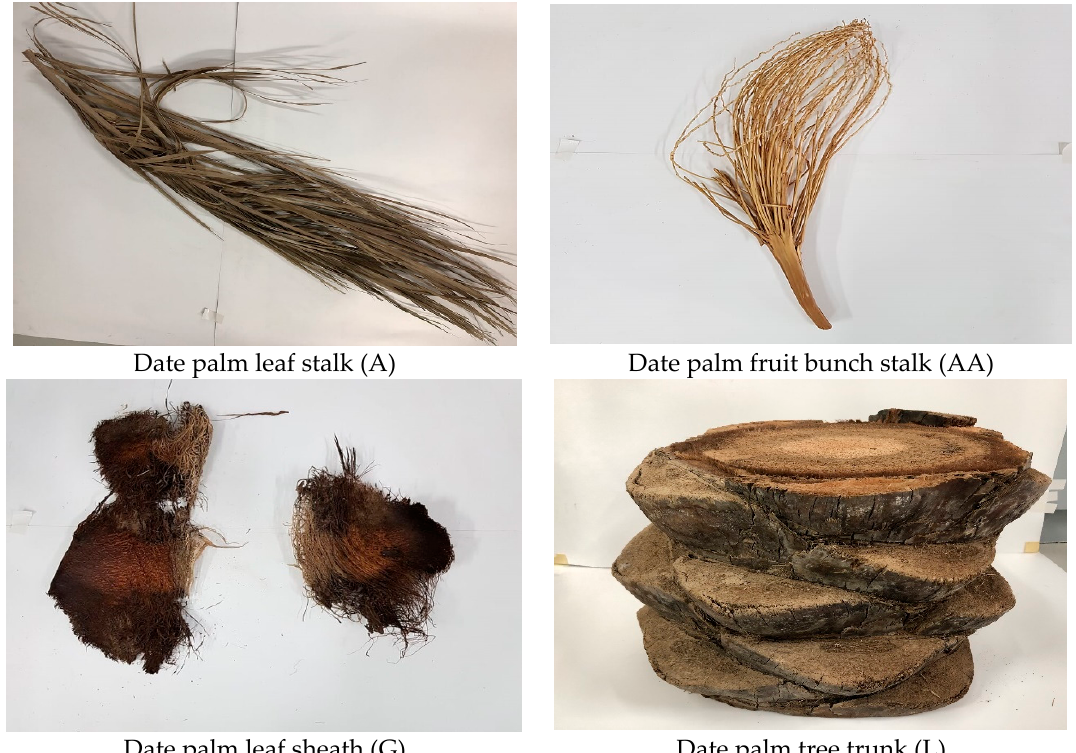
Figure 2. Date palm tree parts used for extracting respective fibers.